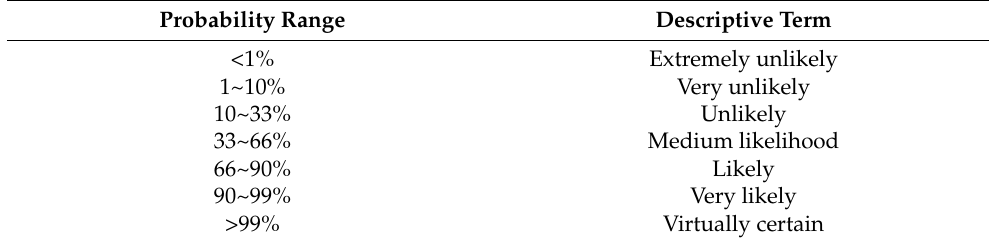
Table 1. The probabilistic result of IPCC.